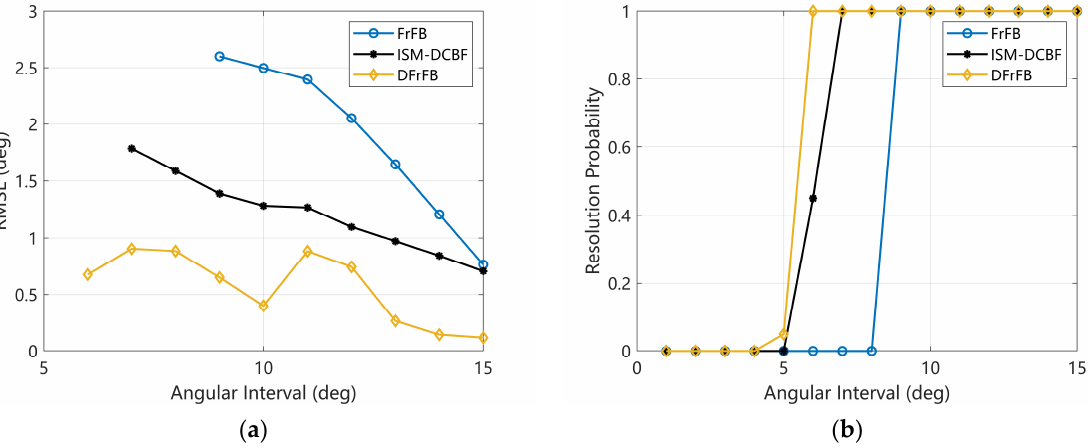
Figure 6. The performances of FrFB, ISM-DCBF, and DFrFB versus different angular intervals. ( a ) The RMSE; ( b ) the resolution probability.